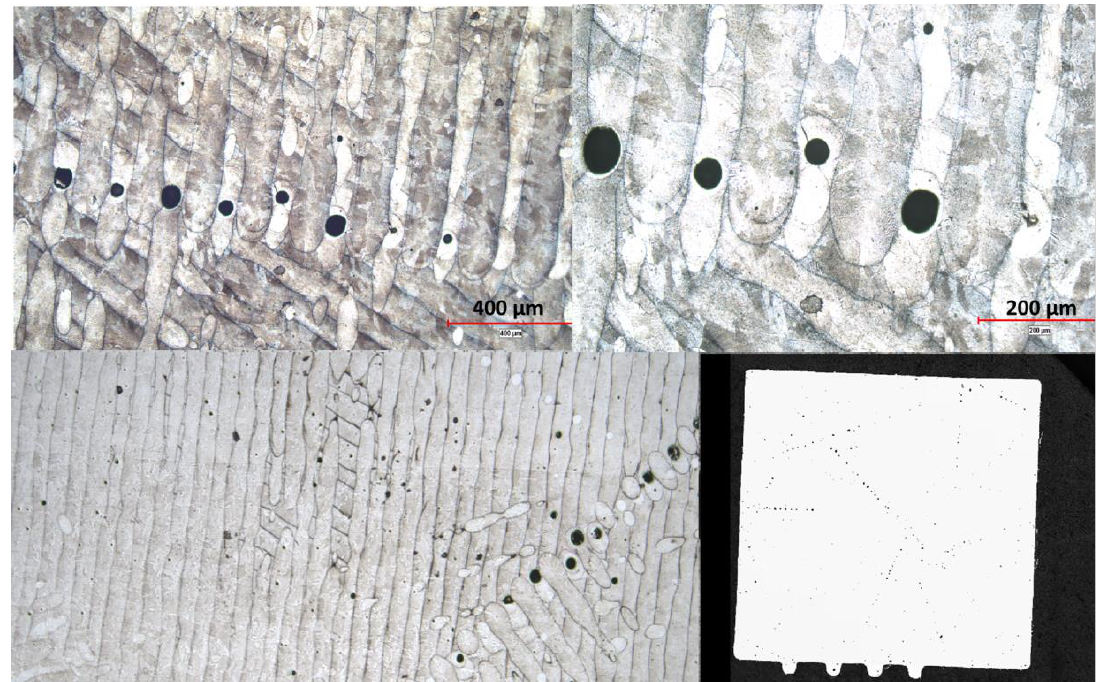
Figure 1. Porosity in SLMed parts: details of rows of pores and test part (200 × 200 mm 2 ).